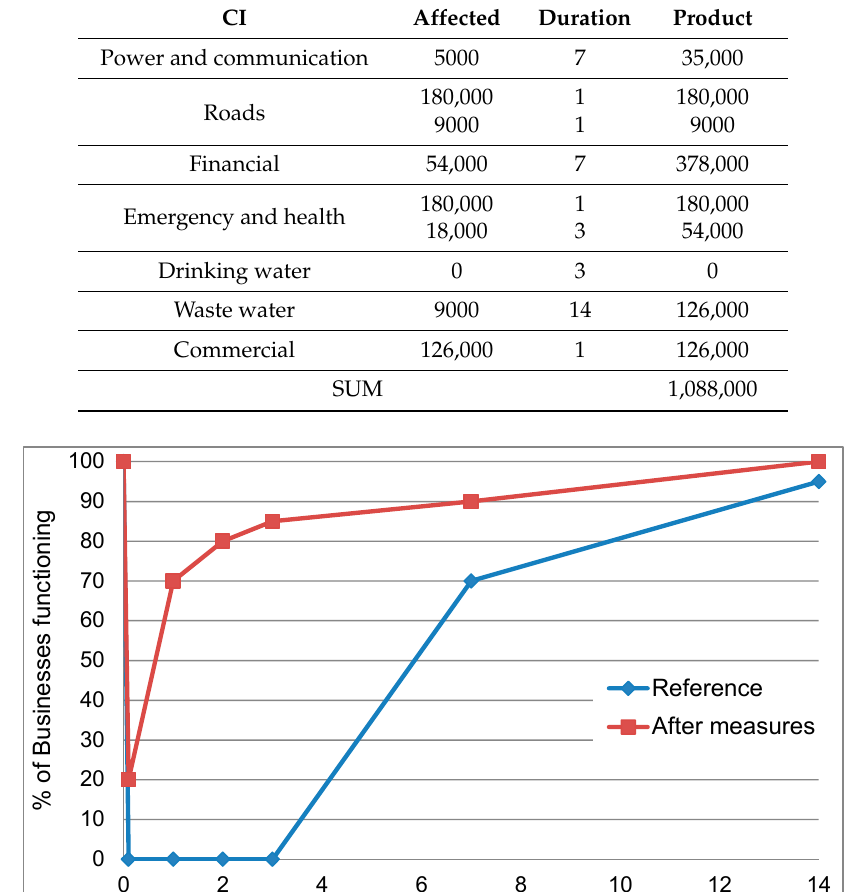
Disruption days in the new situation after implementing the measures with the abovementioned effect.